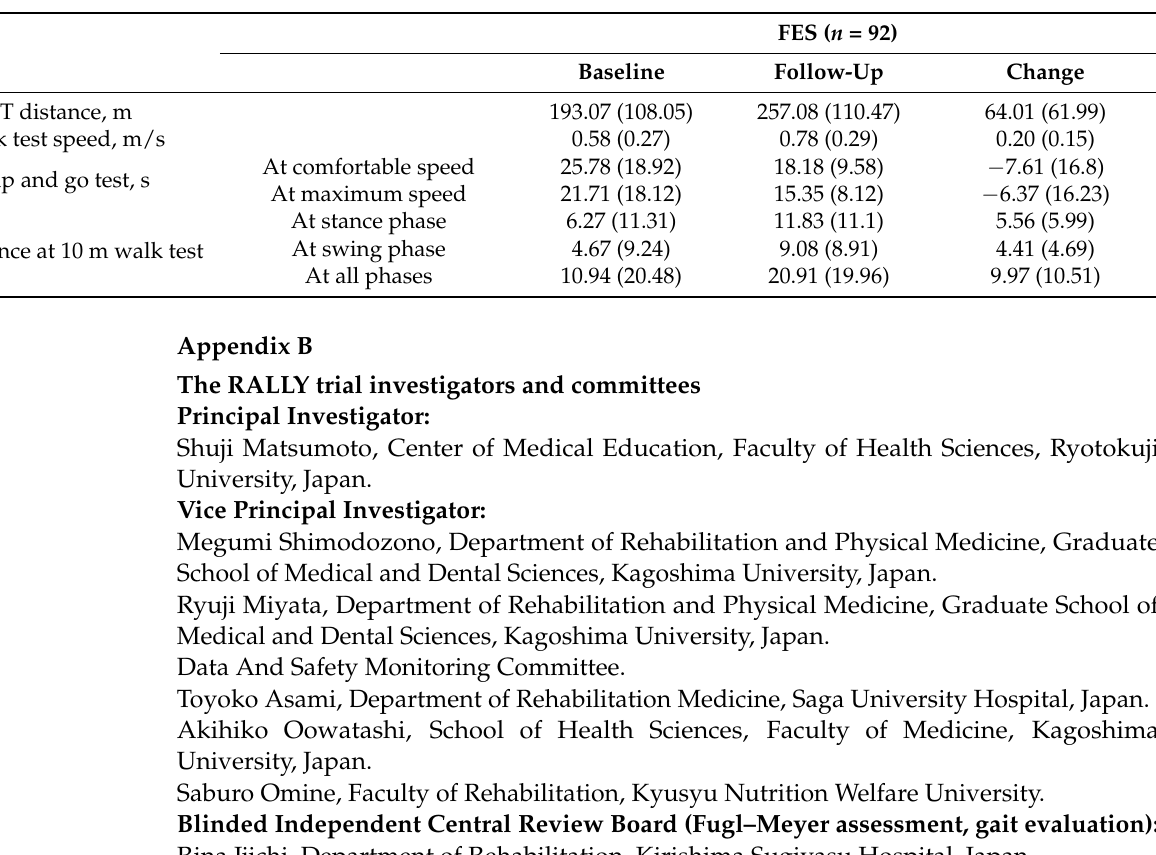
Table A1. Outcomes of examinations with FES. Data are presented as means (SDs). 6-MWT, 6 min walk test; FES, functional electrical